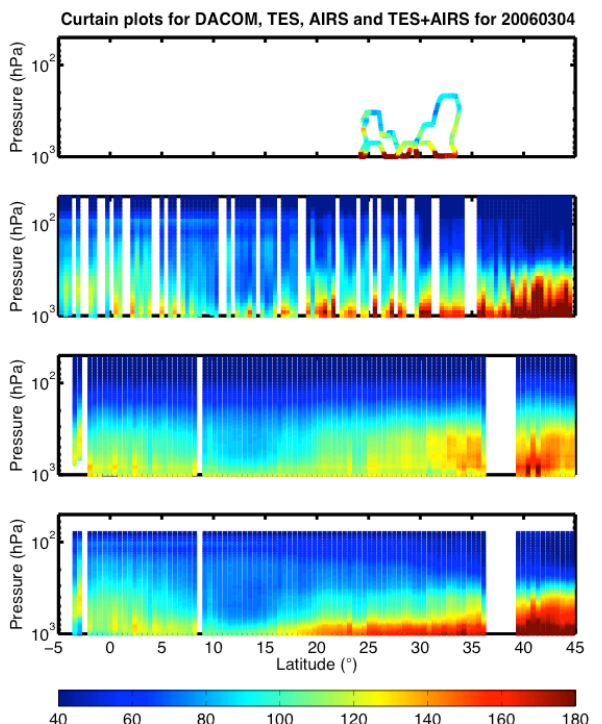
Fig. 8. Curtain plot validation against INTEX-B for AIRS and TES nadir pixels with DACOM CO (top panel), TES CO (2 nd panel), AIRS CO (3 rd panel), and analyzed CO (bottom panel), respectively.